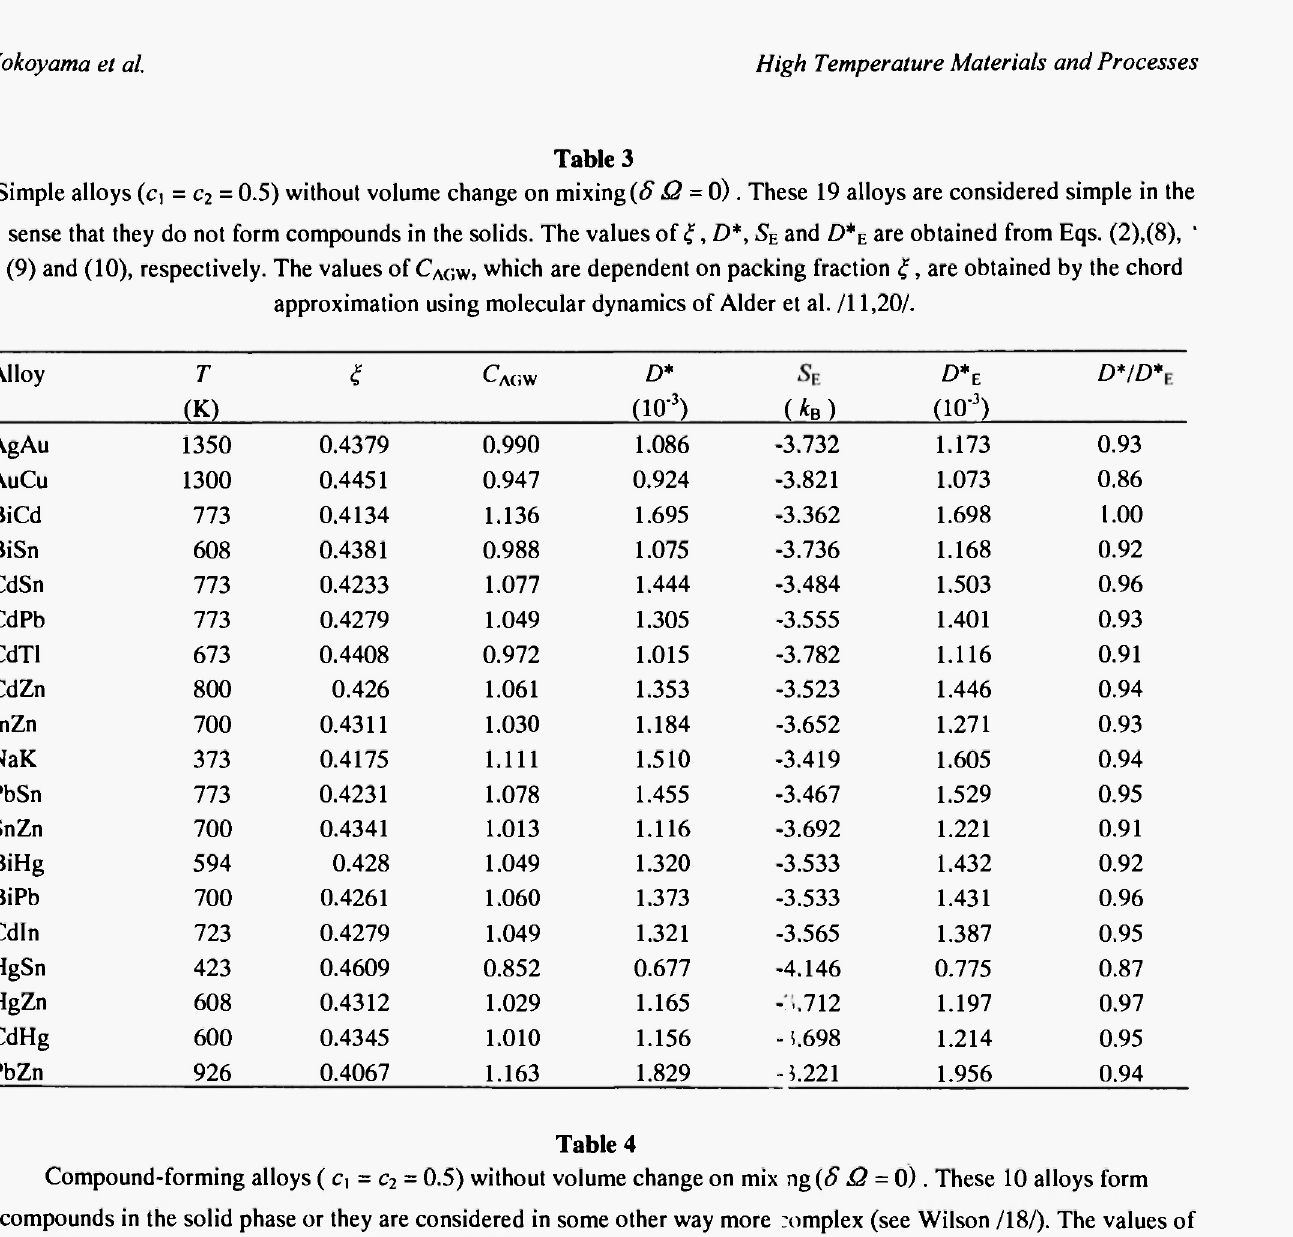
Compound-forming alloys ( C\ = c 2 = 0.5) without volume change on mix r\g(5 Ω = 0). These 10 alloys form compounds in the solid phase or they are considered in some other way more ;omplex (see Wilson /18/). The values of ξ, D*, S E and D* E are obtained from Eqs.(2),(8), (9) and (10), respectively. Tic values of C M;w , which are dependent